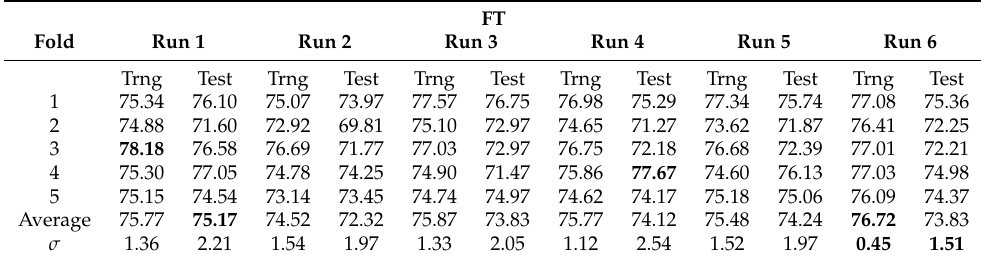
Table 3. Performance of the best individuals of the GBVSBP model for all FT database runs. Each pair of training and testing corresponds to one experiment of the k-fold. Therefore, we obtain 30 executions of our system and report the standard deviation for each run set.